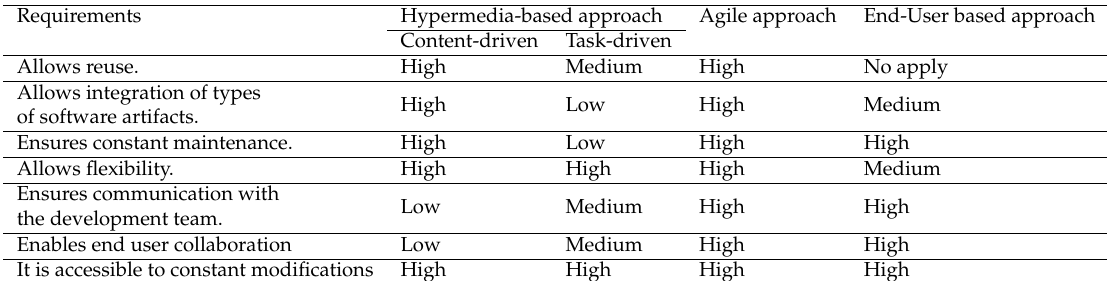
Table 11. Comparison between approaches of web development methodologies.